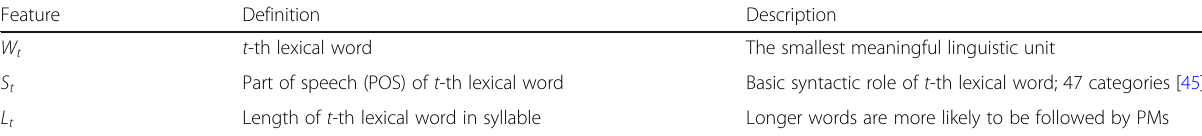
Table 7 Significance of the linguistic features Feature